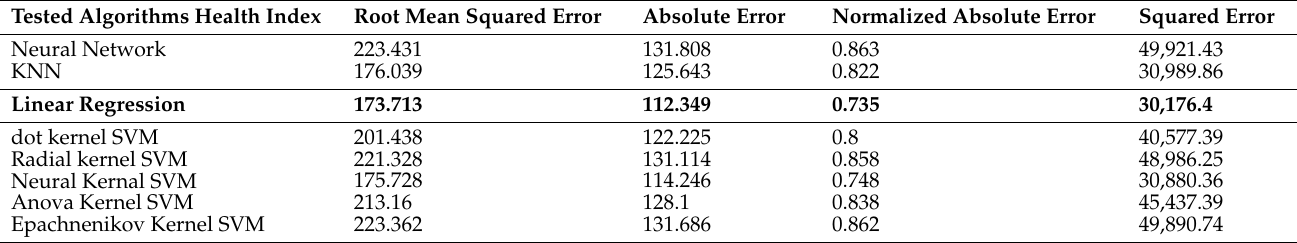
Table 5. Health Index algorithms comparative